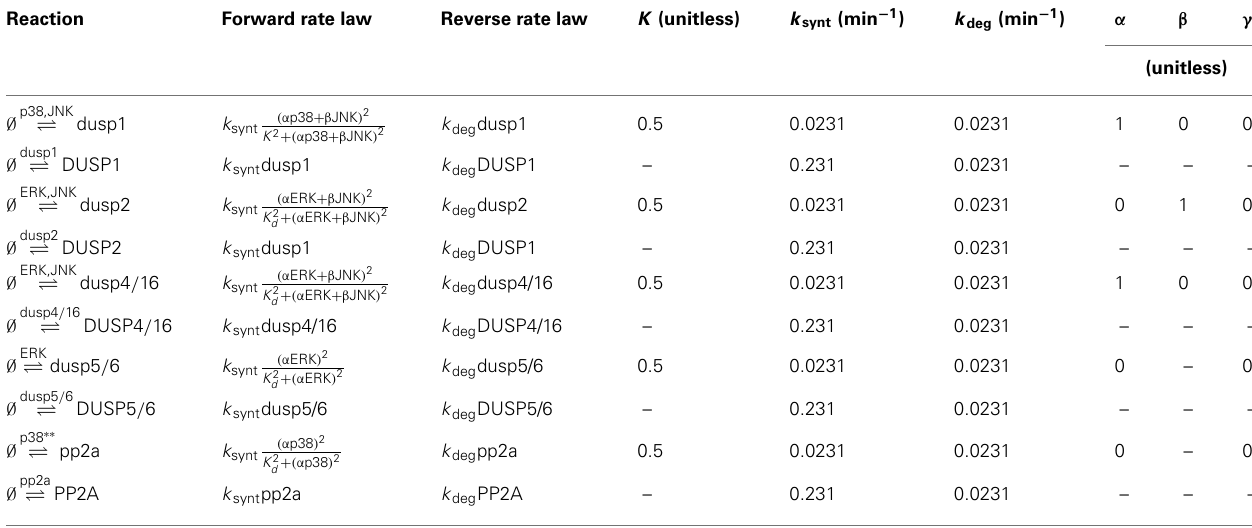
Table 5 | Reactions, rate expressions and parameters of the phosphatase expression processes in the core model.